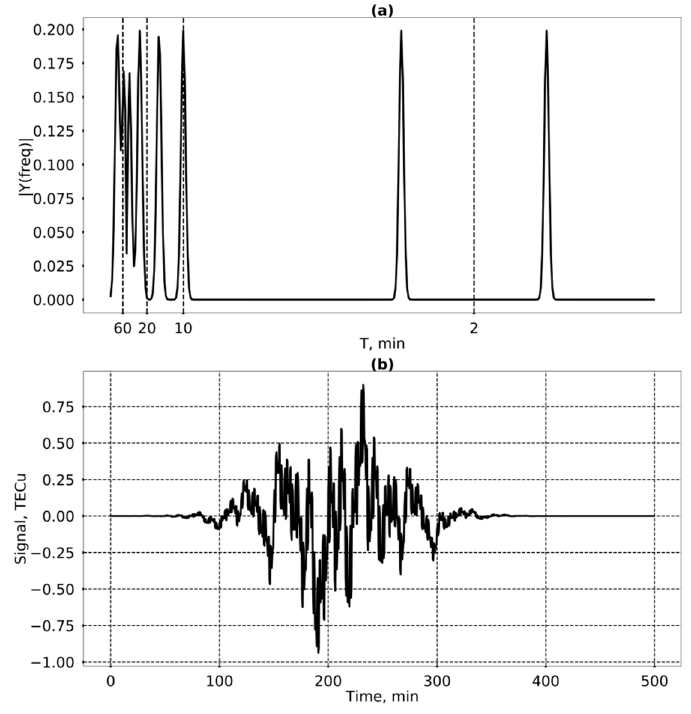
Figure 8. Modeled signal in the frequency ( a ) and temporal ( b ) domains.